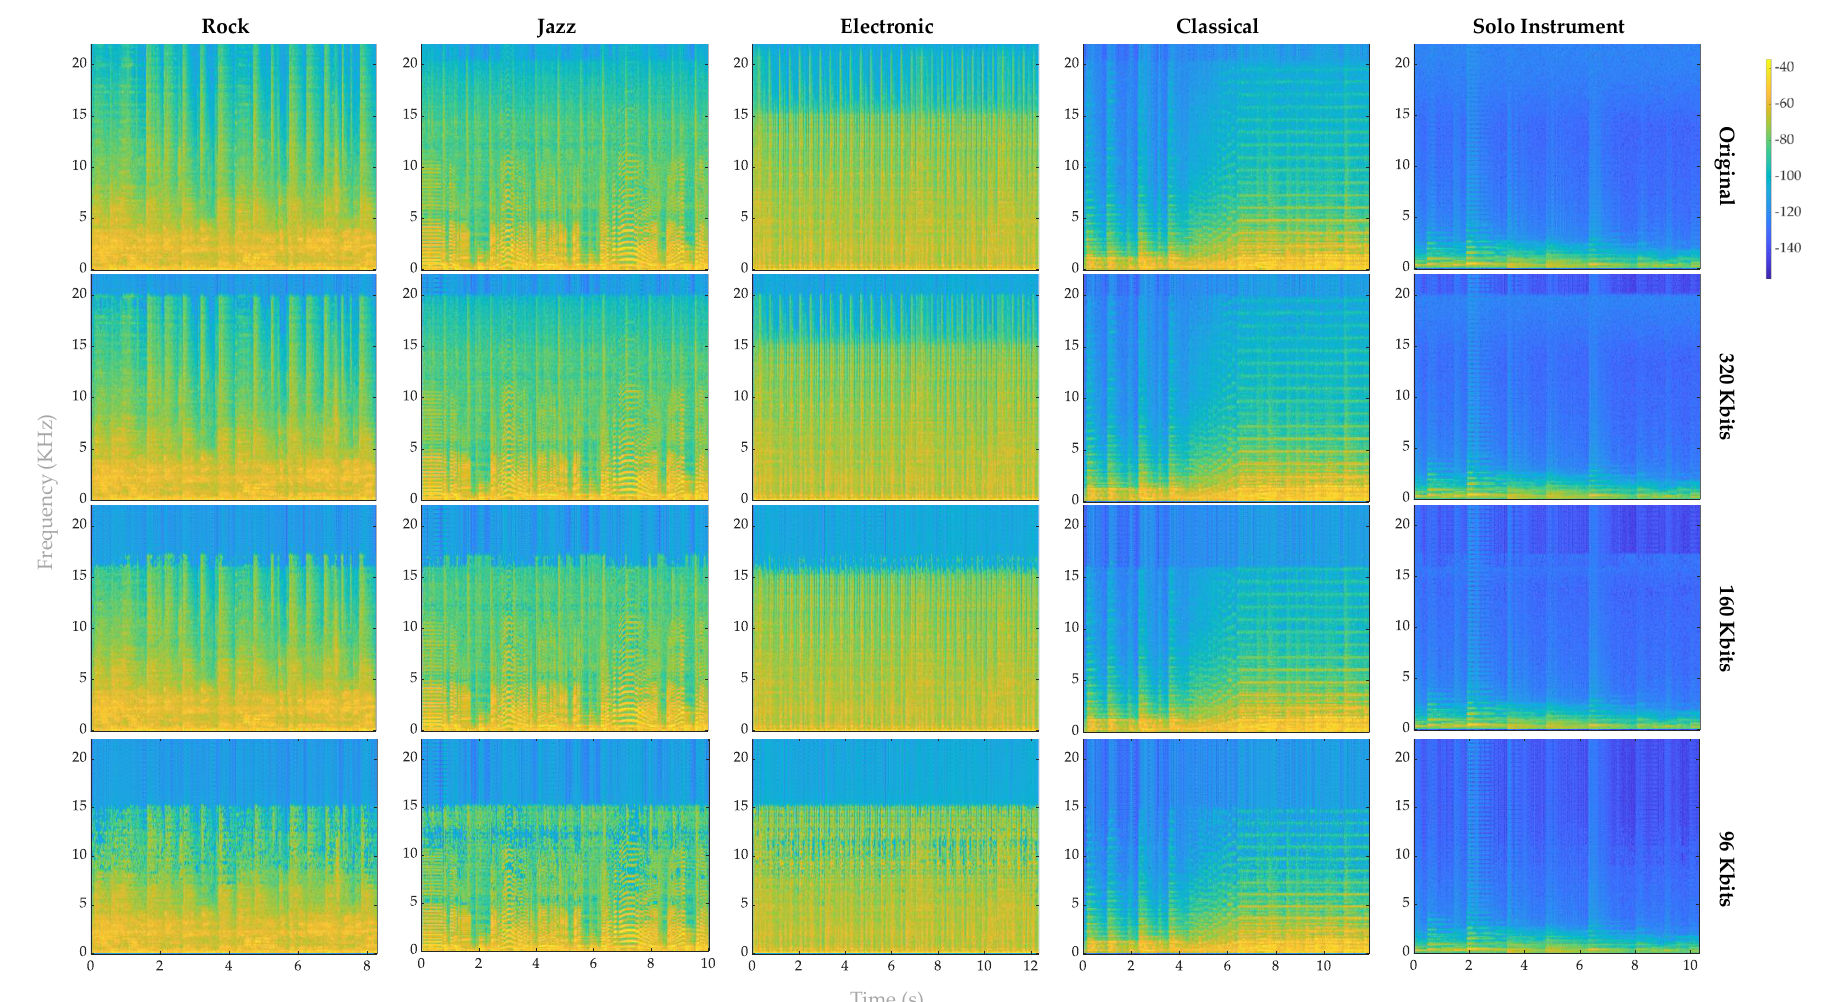
Figure 1. Spectographs of the original and compressed audio files for all the music genres. Scale is common for every audio file and is presented as Power/frequency (dB/Hz).